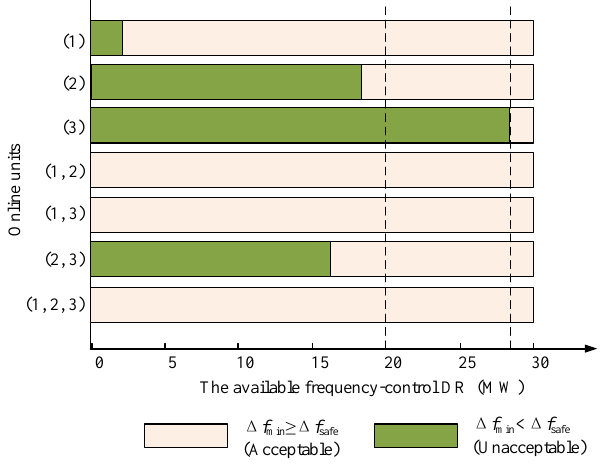
Figure 6. The relationship between Δ f min and Δ f safe with different available frequency-control DR for different combinations of online generation units.